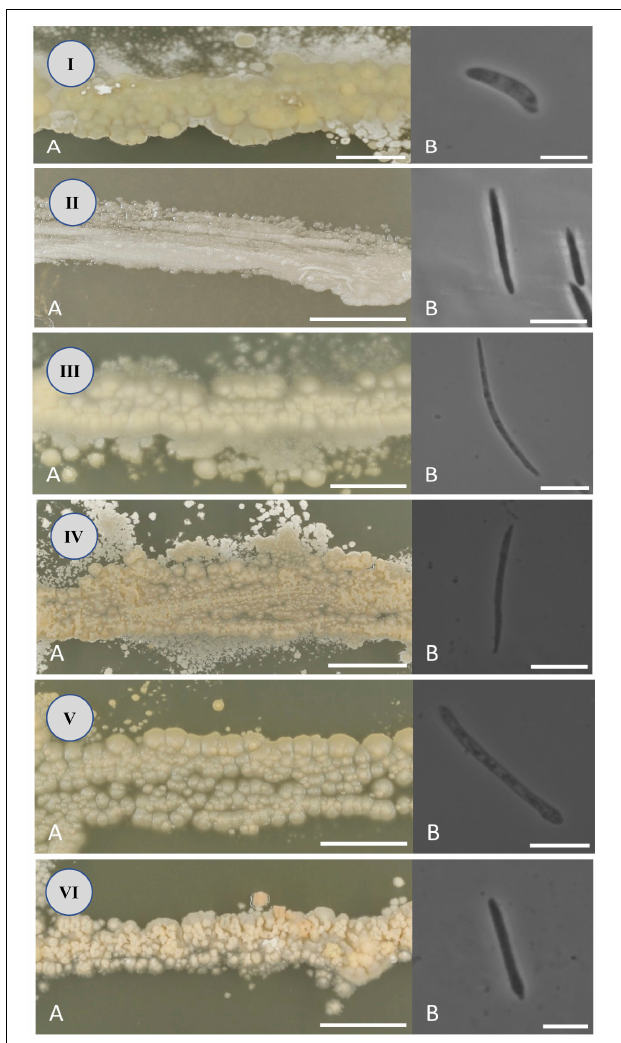
FIGURE 3 | Colony (A) and ballistospore (B) morphology of Jamesdicksonia mali (I) , Golubevia heteromorpha (II) , Entyloma elstari (III) , Entyloma davenportii (IV) , Entyloma belangeri (V) , and Entyloma randwijkense (VI) on potato dextrose agar (bars: A = 10 mm, B = 10 µ m).